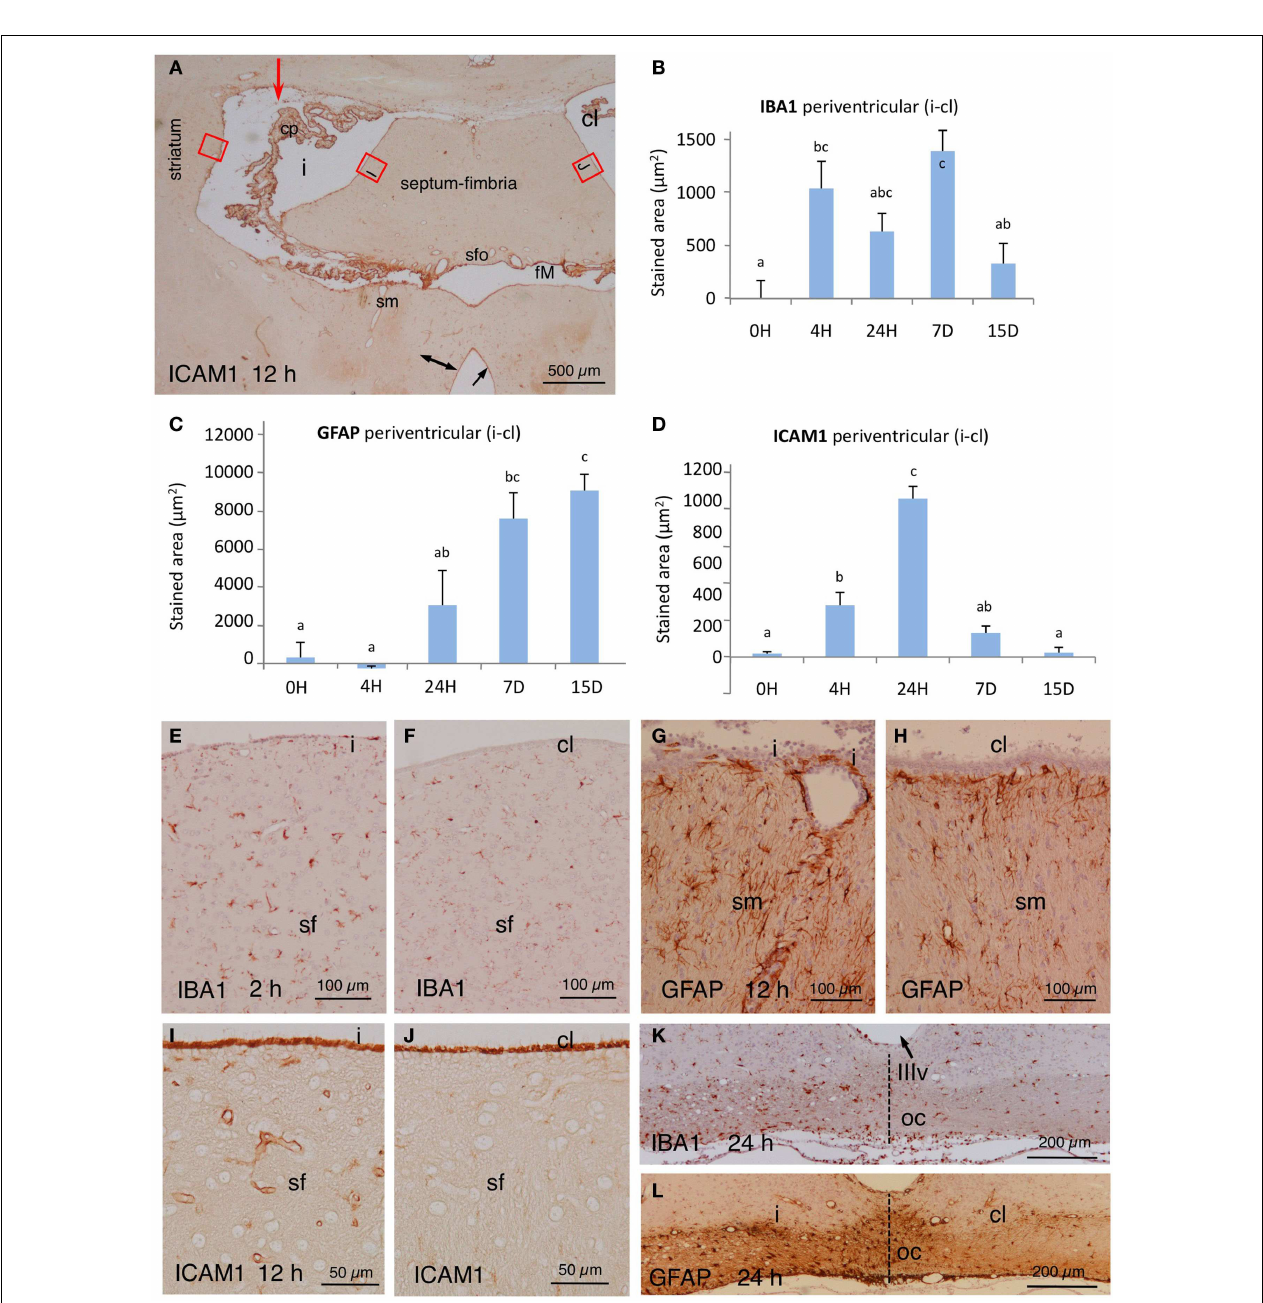
difference between groups ( α = 0.05). (E,F) Immunoreactivity to IBA1 in the periventricular region at the level of the septum-fimbria (sf) in the injected (i) and the contralateral (cl) ventricles, 2h after NA injection. (G,H) Details of GFAP staining in the stria medullaris (sm) in the injected (i) and the contralateral (cl) sides 12h after the administration of NA. (I,J) Details [red squares in (A) ] of the immunoreactivity to ICAM1 in the septum-fimbria (sf) subependymal parenchyma of the injected (i) and the contralateral (cl) sides 12h after the injection of NA. Note the strong immunoreactivity of the ependymal surface in both ventriculi. (K,L) Twenty-four hours after NA injection, the optic chiasm (oc) beneath the third ventricle (IIIv) showed a higher IBA1 and GFAP staining in the injected (i) than in the contralateral side (cl). cl, contralateral ventricle; cp, choroid plexus; fM, foramen of Monro; i, injected lateralventricle; sfo, subfornical organ; sm, stria medularis; sf, septum-fimbria; oc, optic chiasm; IIIv, third